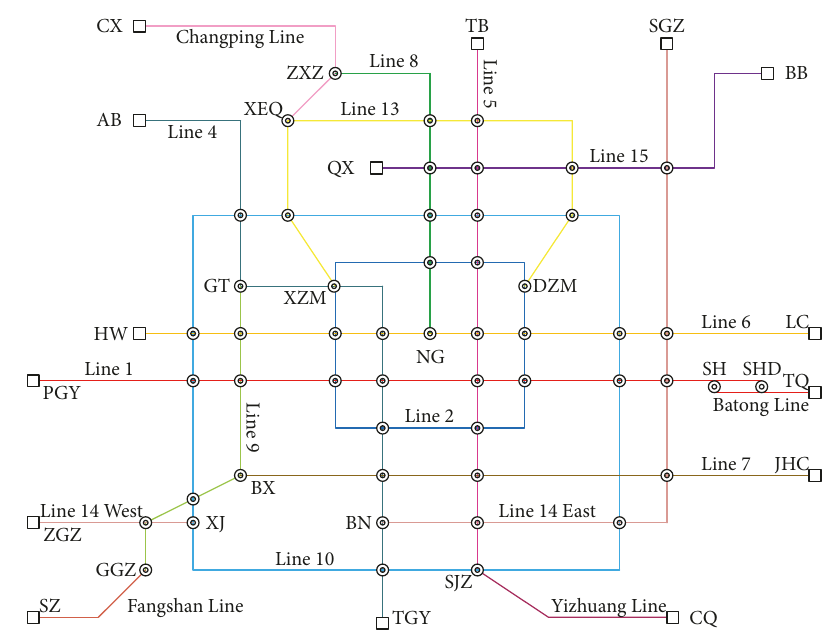
Figure 3: Sketch map of the Beijing subway network without Airport Express. Table 1: A sample of the AFC data with key